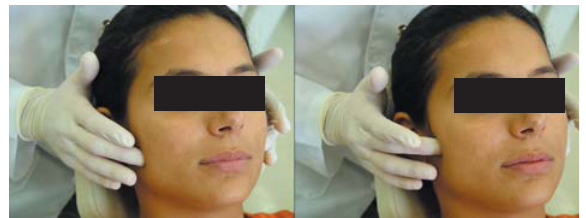
FIGURE 5- Palpation of the superficial and deep masseter muscle